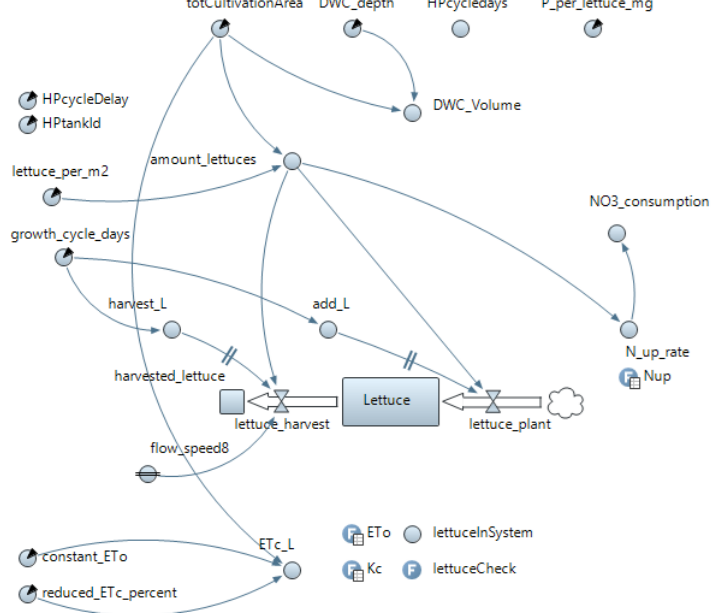
Figure A4. Software diagram of the hydroponic system consists of water, nitrogen, and phosphorus balances. The water balance is affected by the evapotranspiration rate under the given conditions, the nutrient and phosphorus balance is linked to the lettuce nutrient uptake and the inflow from RAS and ANRC. A negative nutrient stock means that additional nutrient supplementation is